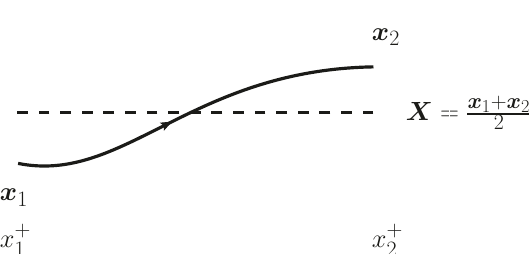
Figure 6 . Approximation of the (non-eikonal) scalar propagator inside the target by a Wilson line (times a free propagator) in the PTE scheme evaluated at the mean transverse position X = ( x + x ) / 2 2 1